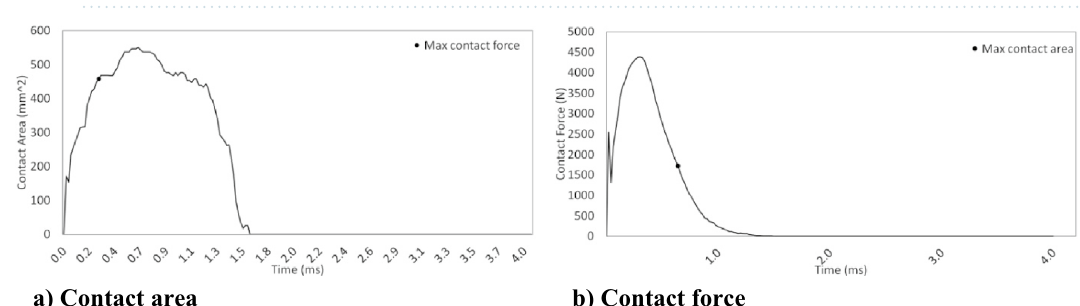
Figure 10. Time histories of the impact of the hailstone on specimen